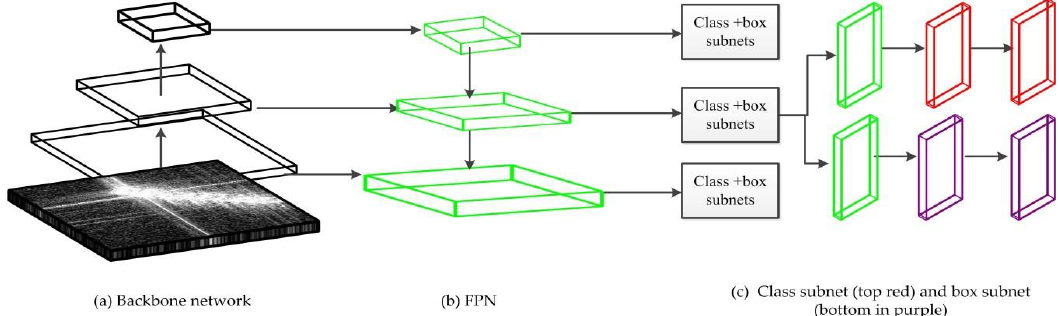
Figure 1. The architecture of RetinaNet: The green parts are the pyramidal features extracted by feature pyramid networks (FPN). The red and purple parts are the classification subnetworks and the box regression subnets, respectively. ( a ) indicates the backbone network and it can be VGG, ResNet, or DenseNet to extract features. ( b ) is FPN to obtain the multi-scale features. ( c ) illustrates that there are two subnets, i.e., the top red one for classification and the purple bottom for bounding box regression.